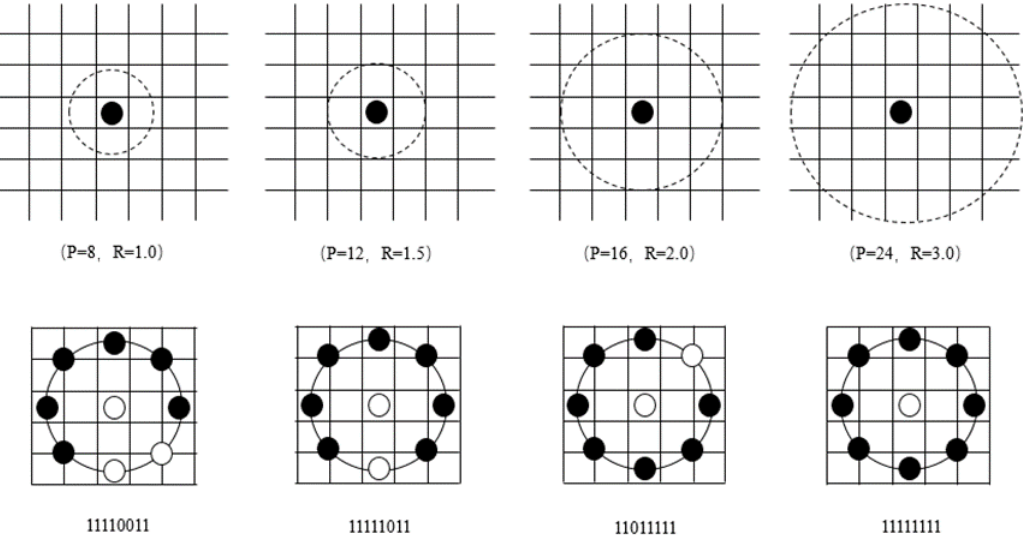
Figure 2. Improved LBP ( P,R ) . The above section draws an example diagram of the selection in (P,R). The bottom half of figure is an example of (P,R) = (8,2). It is easier to understand Figure 2 when combined with Figure 1.